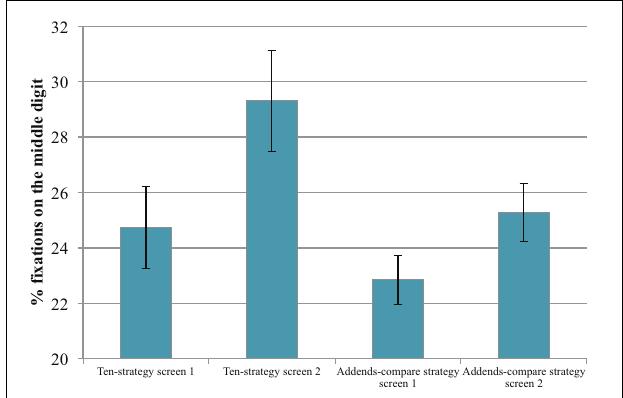
FIGURE 2 | Percent fixation frequency on second addend for ten-strategy and addends-compare strategy booklets. The error bar displays the standard error of the